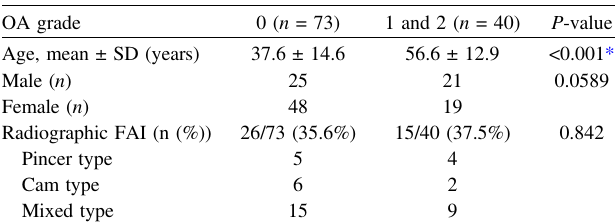
Table 2. Relationship between osteoarthritis (OA) grade and the patients ’ characteristics ( n = 113).